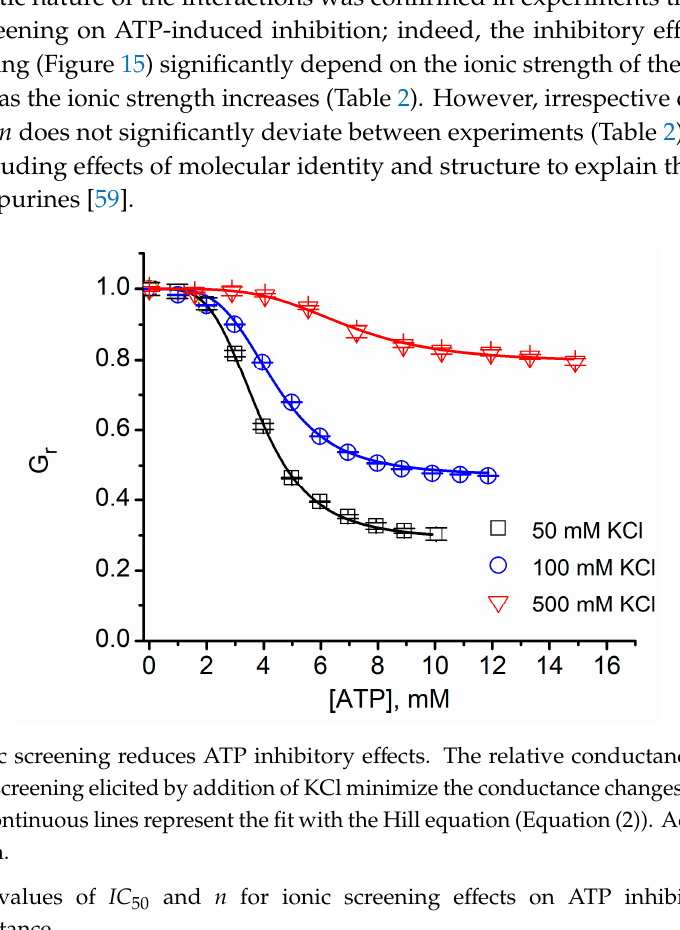
Table 1. Fit values of IC 50 and n for ATP, ADP, and AMP inhibition effects on lysenin channel conductance.